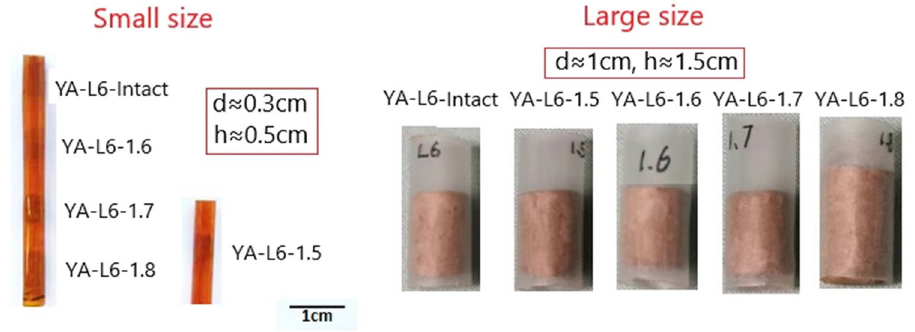
Figure 6. The small size and large size samples (small size samples for CT&MIP tests and large size for MIP test only).